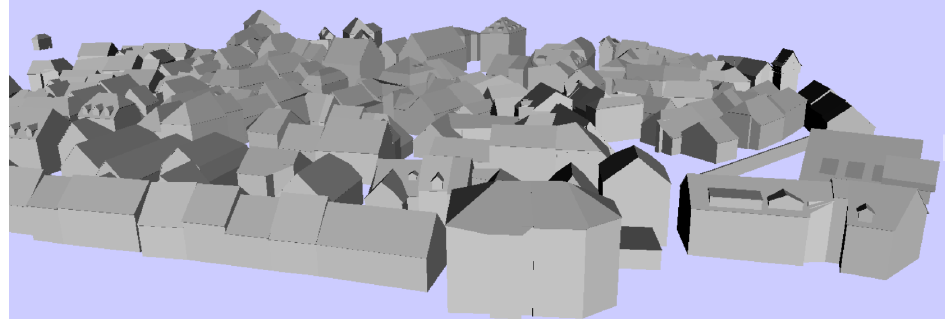
Figure 10. Original LOD3 model (LOD3).